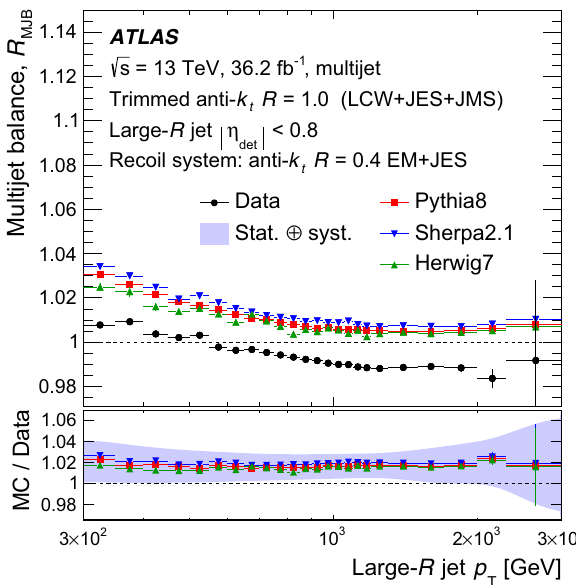
Fig. 12 Mean transverse momentum balance R MJB for leading- p T large- R jets( | η | < 0.8)balancedagainstasystemofatleasttwosmall- R jets ( p T ≥ 25 GeV, | η | < 2.8) as a function of the large- R jet transverse momentum p T . The measured balance is compared with the prediction of Monte Carlo simulations based on the event generators Pythia 8, Sherpa 2.1, and Herwig 7. Below, the ratio of response measurements in data and simulation is presented. The shaded band indicates the total uncertainty of the measurement, described in detail in the text. For each p ref bin, the measured R DB is plotted against the average jet p T of the T bin. The horizontal error bars gives an indication of the width of the associated p ref bin T